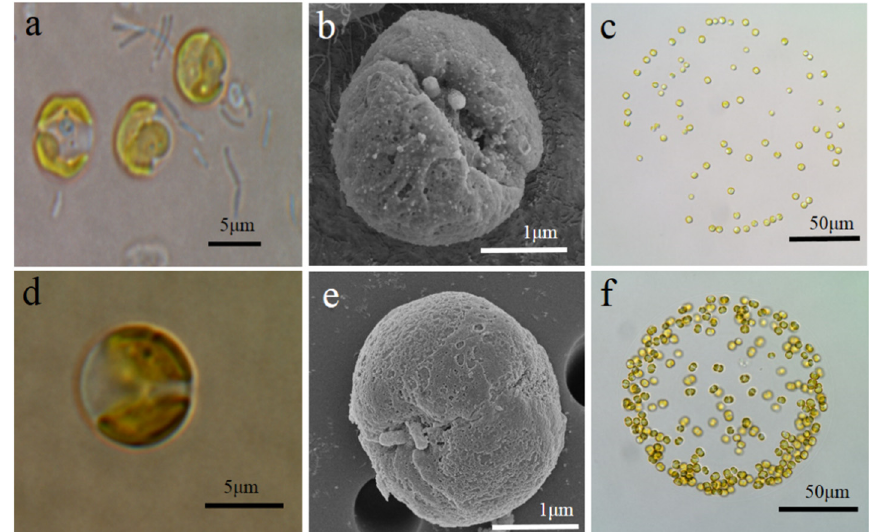
Figure 1. LM and SEM photographs of colonial cells and colonies. ST colonial cell showing the two short appendages inserted near the center of the apical pole and a colony (200 μ m) embodying 60 colonial cells ( a – c ); GX colonial cell showing the two short appendages and a colony (150 μ m) embodying 140 colonial cells ( d – f ).